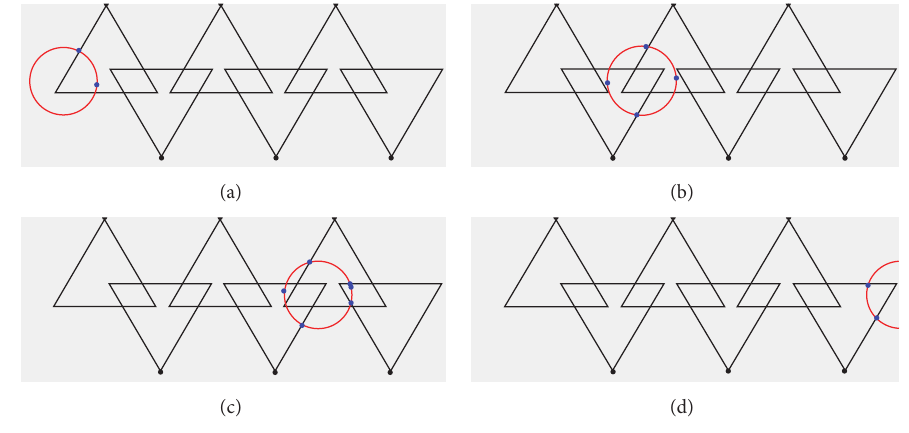
Figure 12: Cars moving through the considered